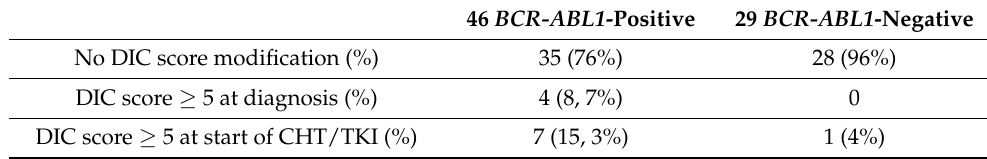
Table 4. Description of ISTH-DIC